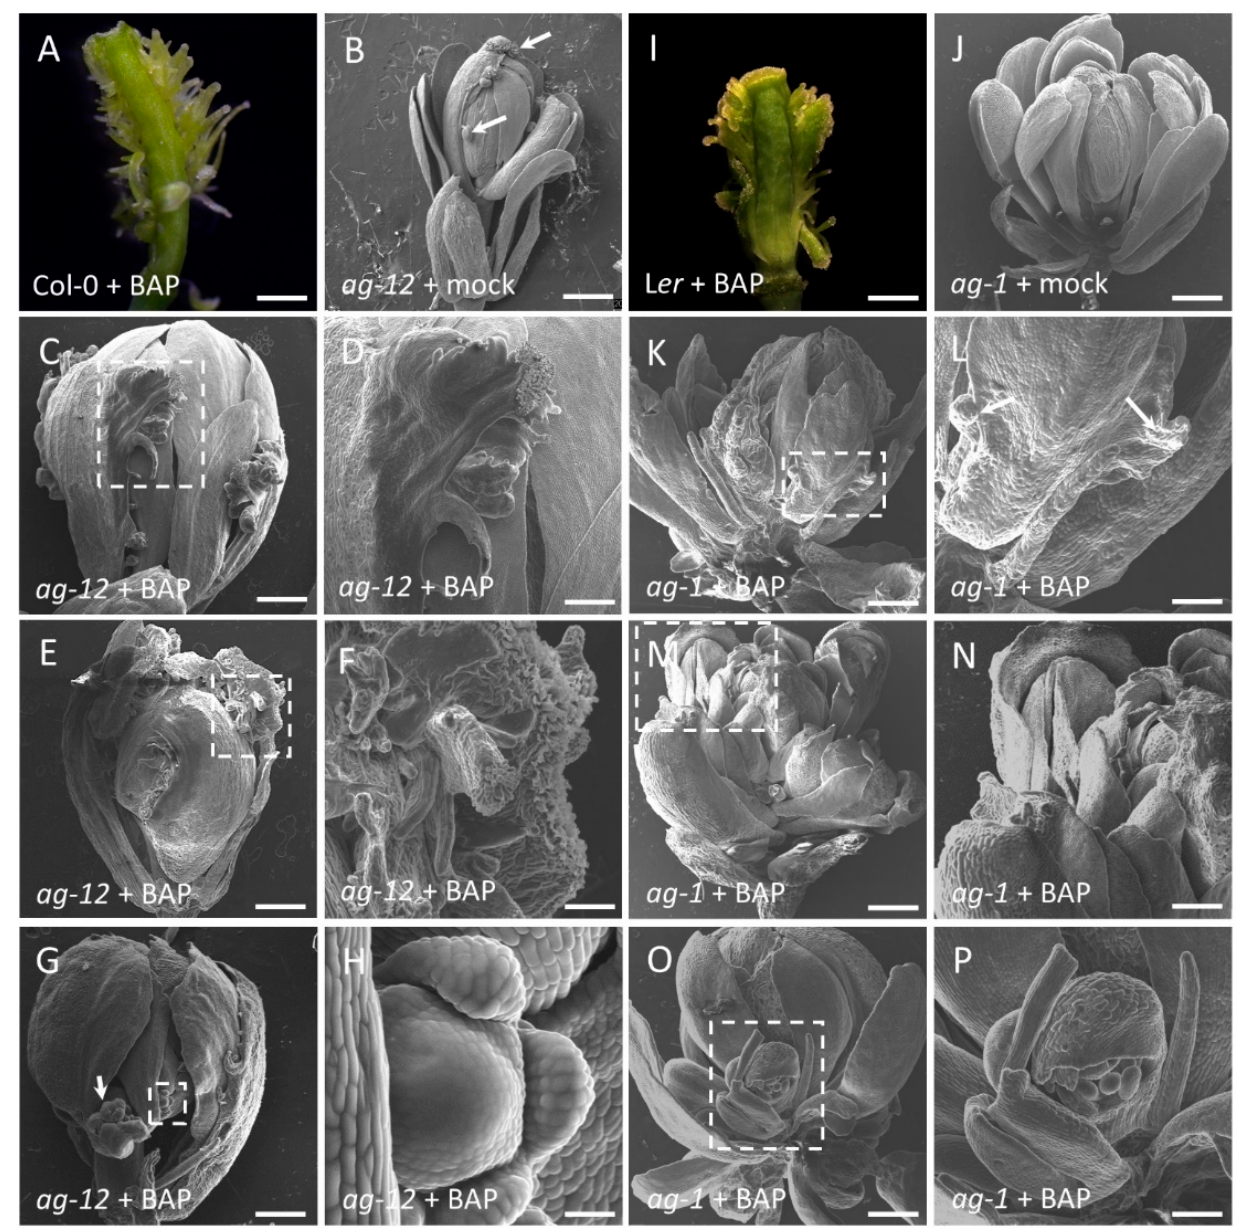
Figure 1. Cytokinin-induced carpeloid structures and secondary floral buds in flowers of plants lacking AG activity. Scanning electron micrographs of floral phenotypes of ag mutant plants treated with mock or cytokinin (100 µ M BAP) solution; pictures are of one week after the treatment. ( A ) Micrograph of a gynoecium Col-0 treated with cytokinin solution. ( B ) Mock-treated ag-12 flower showing ectopic ovules and stigmatic papillae structures (as indicated by the white arrows). ( C – H ) BAP-treated ag-12 flowers, stigmatic and carpeloid structures are visible. ( D , F ) Close up from dotted white square in ( C ) and ( E ), respectively. ( G ) BAP-treated ag-12 flower showing floral buds (as indicated by the white arrow). ( H ) Close up from dotted white square in ( G ) showing a floral meristem. ( I ) Micrograph of a gynoecium L er treated with cytokinin solution. ( J ) Mock treated ag-1 flowers without carpeloid structures (some sepals and petals were removed). (K – N) BAP-treated ag-1 flowers (some sepals and petals were removed) showing only some proliferating tissue (as indicated by the white arrows). ( L , N ) Close up from dotted white square in ( K ) and ( M ), respectively. ( O ) BAP-treated ag-1 flower showing a floral bud (as indicated by the dotted white square). ( P ) Close up from dotted white square in ( O ) showing a floral bud. ( D , F , H , L , N , P ) Close up from dotted white square with a higher magnification. Scale bars: ( B – G , J – O ) 200 µm, ( A , I , P ) 100 µm, ( H ) 30 µm. 3.2. Cytokinin Induces AG Targets Involved in Gynoecium Development Three genes have been reported to induce carpel features independently of AG: CRABS CLAW (CRC), SPATULA (SPT), and SHATTERPROOF 2 (SHP2) [16,19]. We wondered whether one or more of these genes could be induced by cytokinin, thus explaining the observed carpeloid features in the ag-12 BAP-treated flowers. In wild type flowers, either Col-0 or L er , all three genes are induced 24 h after BAP treatment,